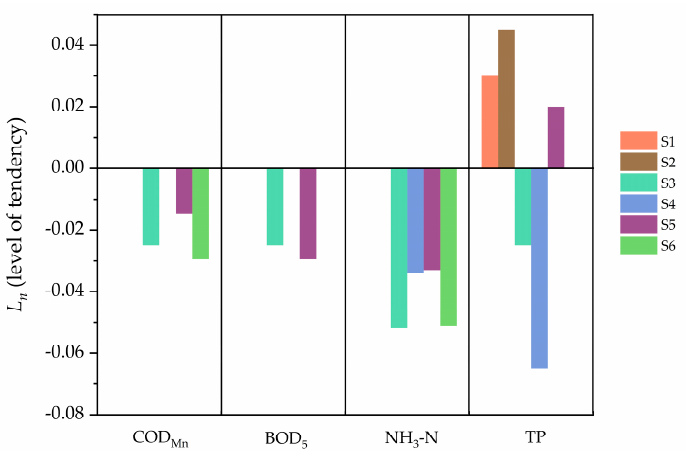
Figure 6. The trend level of each water quality parameter in each site.